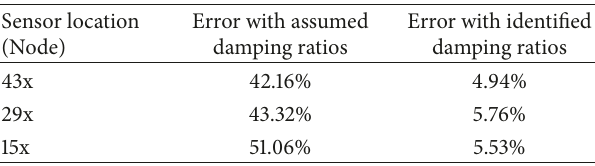
Table 11: The relative errors in the measured and analytical